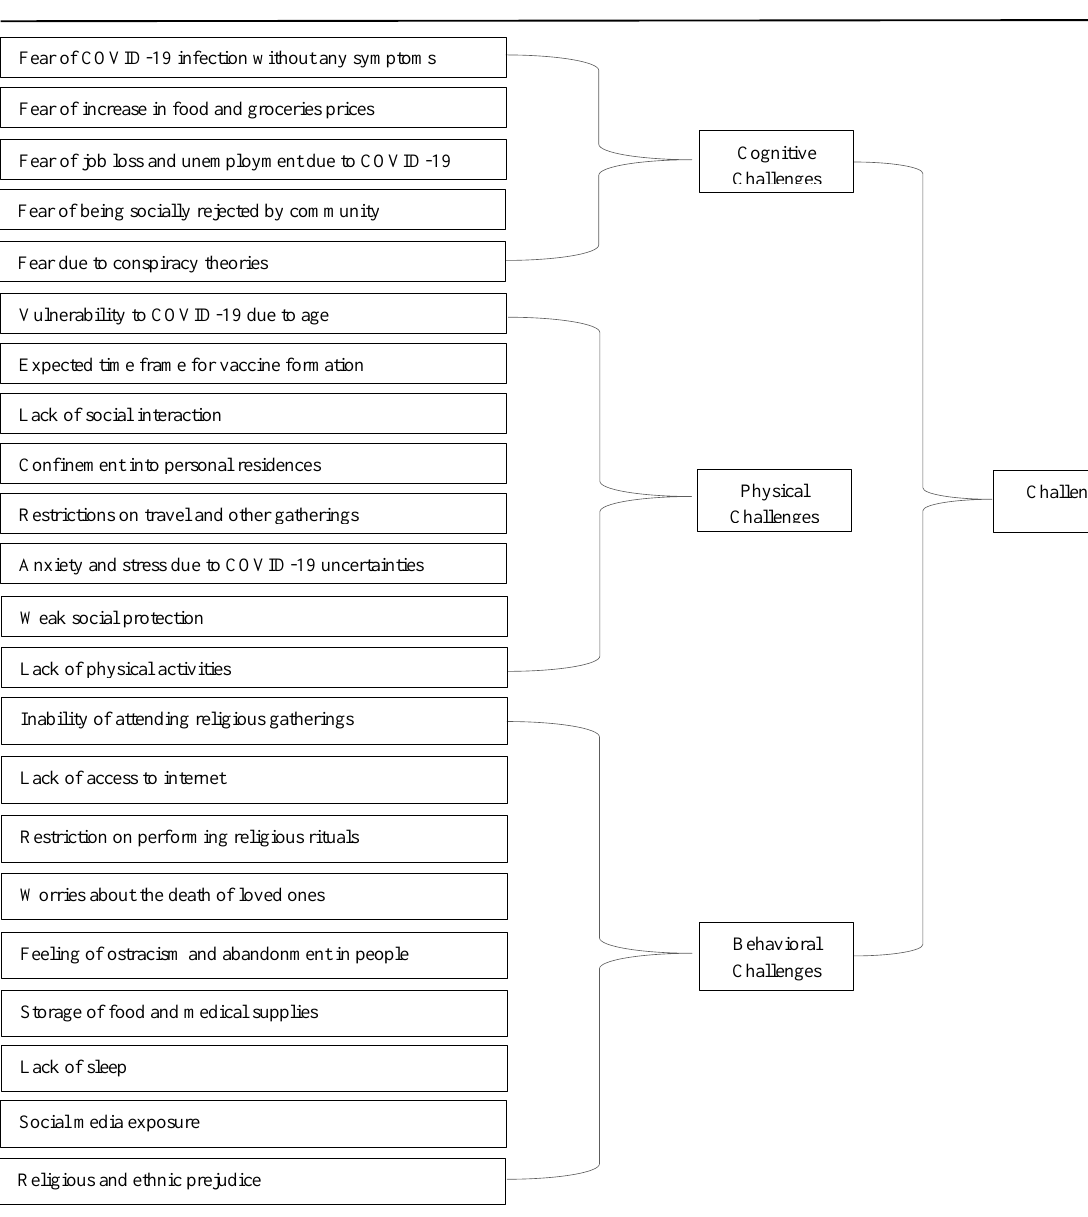
Figure 1: Categorization of data in sub-themes and themes